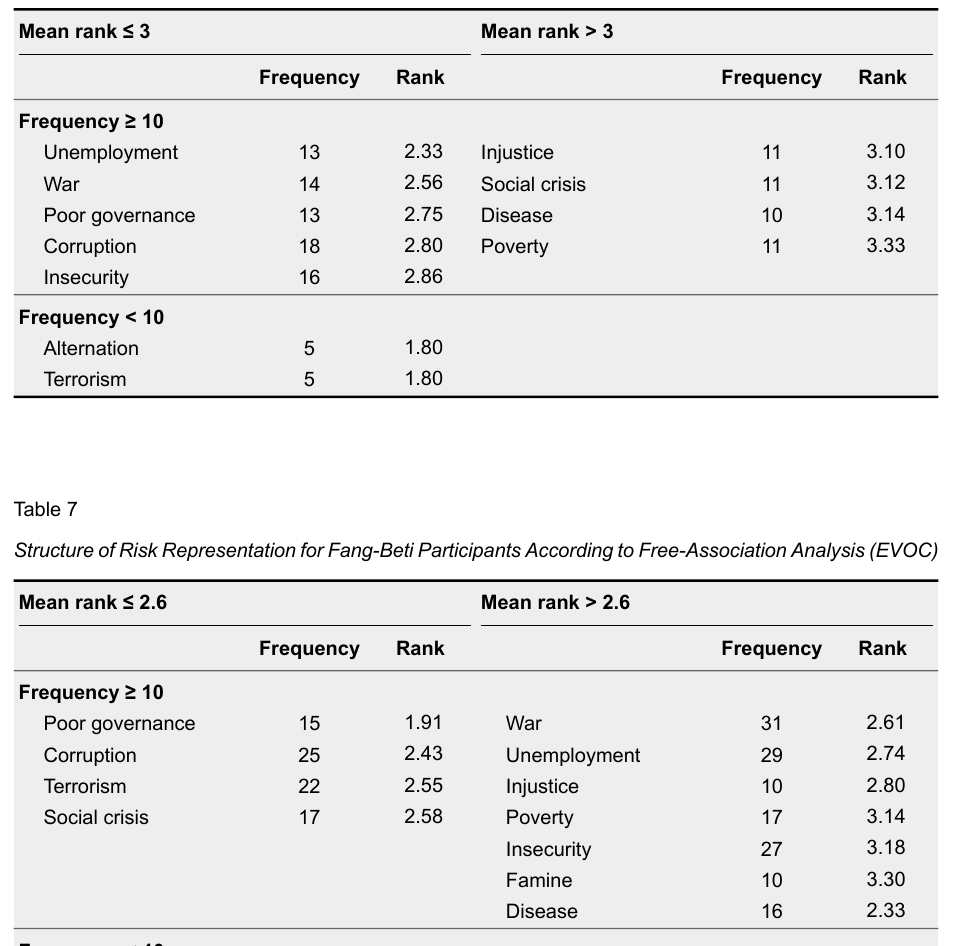
Structure of Risk Representation for Grassfields Participants According to Free-Association Analysis (EVOC)